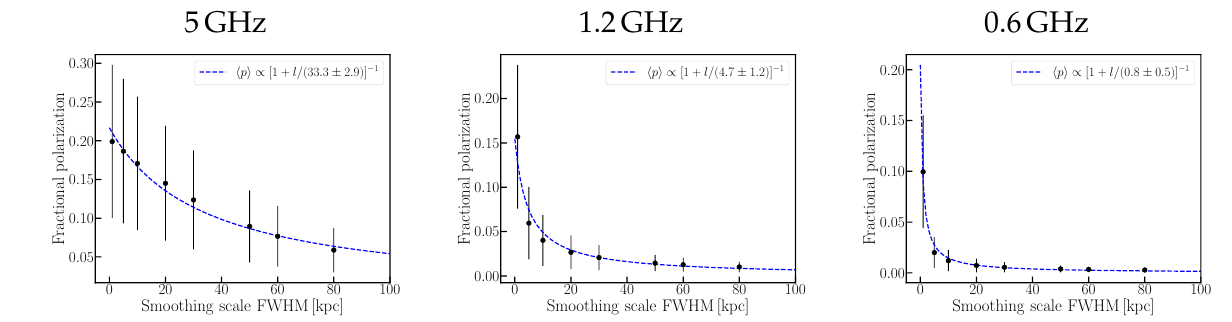
Figure A1. Same as Figure 5 for l f = 102.4kpc at t / t ed = 20.2. 5 GHz 1.2 GHz 0.6 GHz